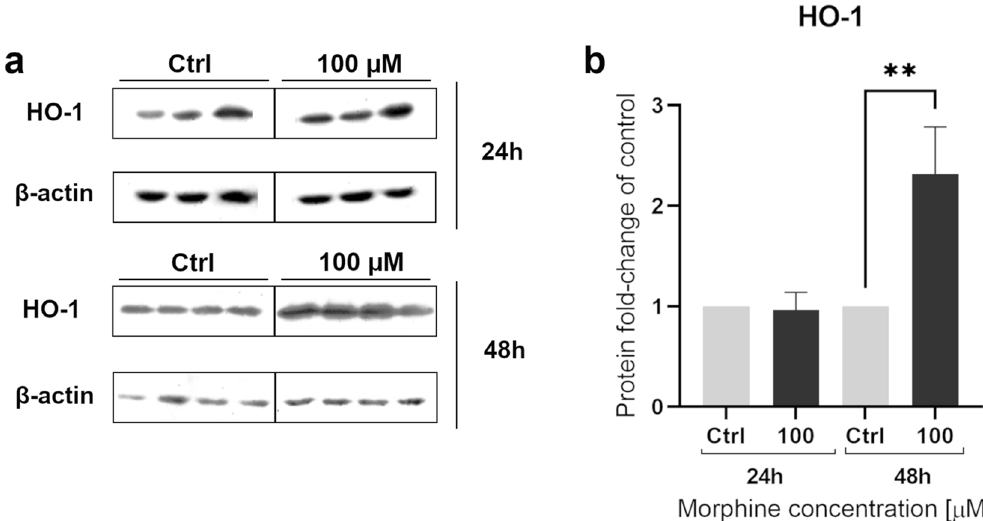
Figure 3. Western blot analyses of heme oxygenase 1. Western blot analyses of heme oxygenase 1 (HO- 1) as verification of proteomic results, were performed on HBMECs treated for 24 h and 48 h at 100 µM. Quantification of actin level was used for normalization. Data are represented as means ± SD of three biological replicates for 24 h and four biological replicates for 48 h. The conditions 24 h and 48 h represent two different blots. Full Western blot images can be found as Supplementary Figure S3. Statistical significance of each measure from treated cells toward the control culture was evaluated with an unpaired t -test. Significant p -values: ** p -value < 0.01. Ctrl =